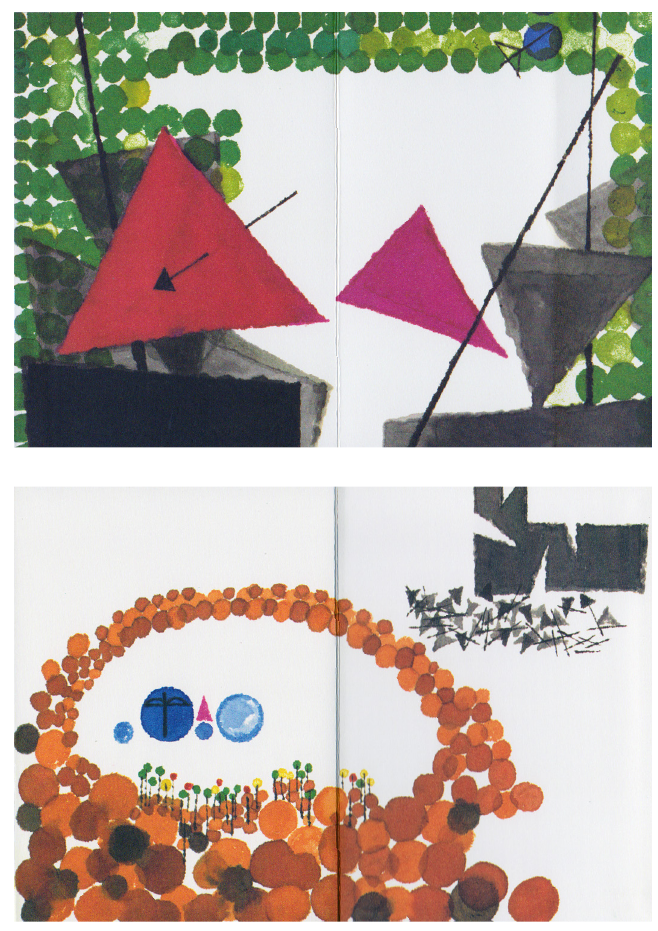
Fig. 13 Warja Lavater, Tell